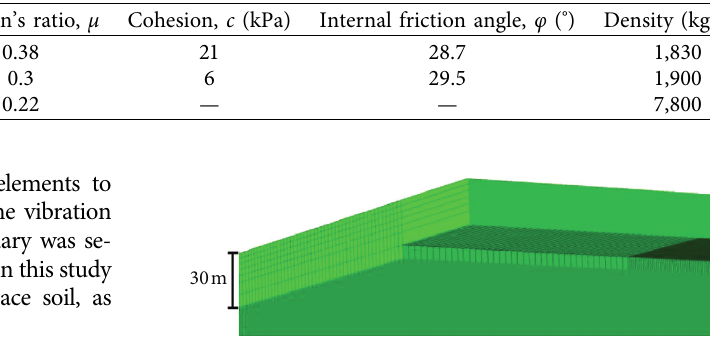
Table 1: Soil parameters.